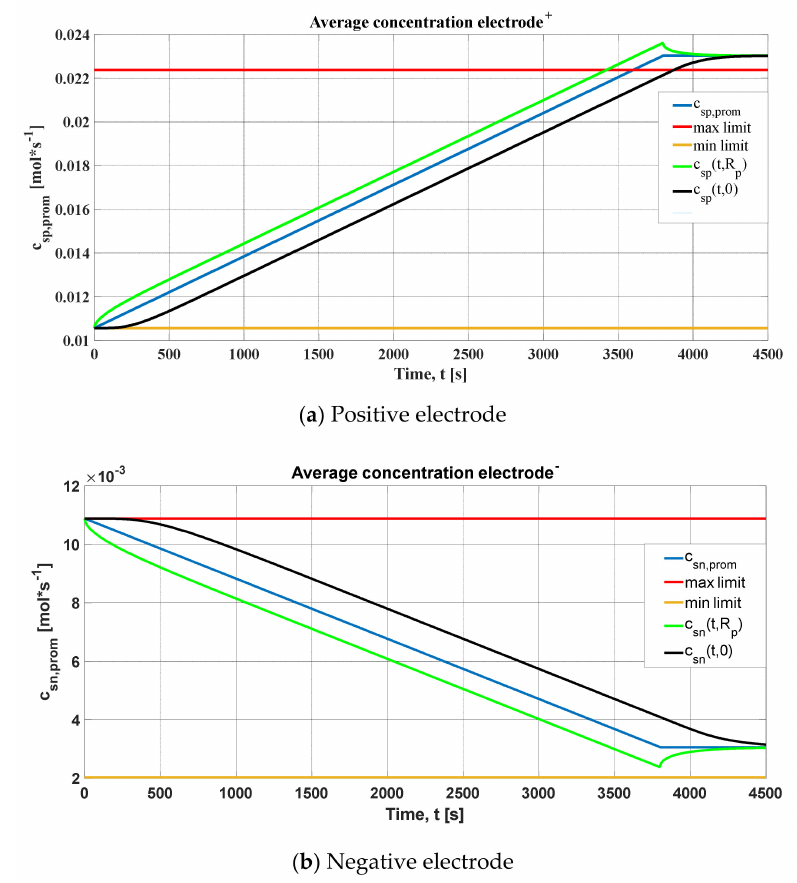
Figure 9. Average (Li + ) concentrations in both electrodes of the cell (SPM): ( a ) positive electrode; ( b ) negative